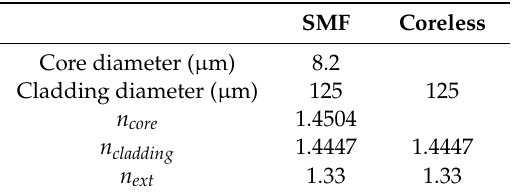
Table 1. Simulation parameters at 1550 nm. Material dispersion calculated from